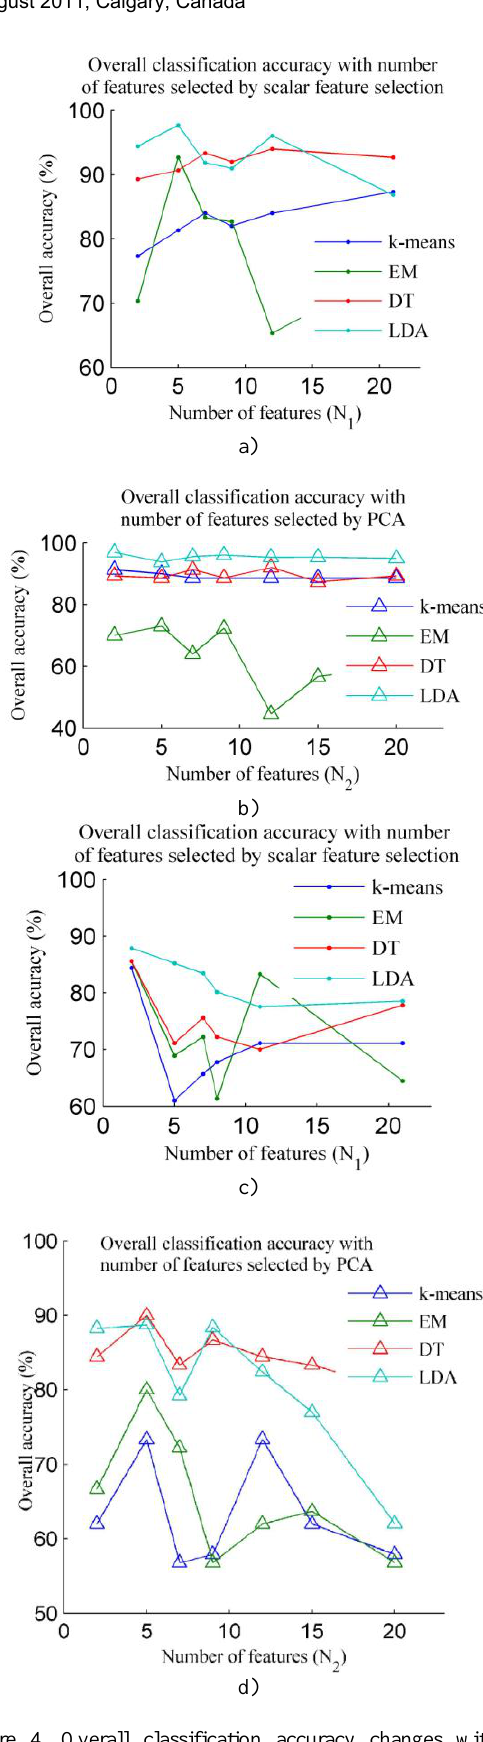
Figure 4. Overall classification accuracy changes with the number of features selected by two feature selection methods,